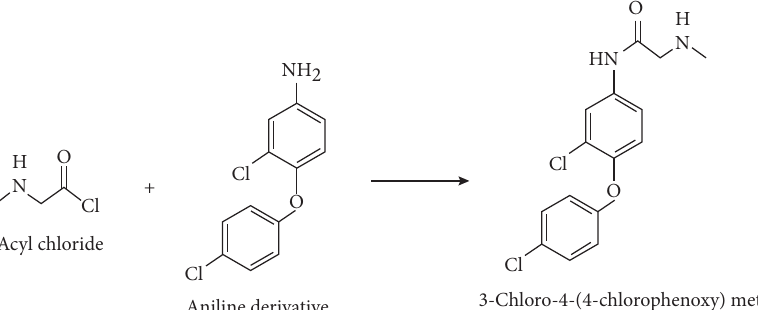
Figure 4: Coupling acyl chloride to aniline.